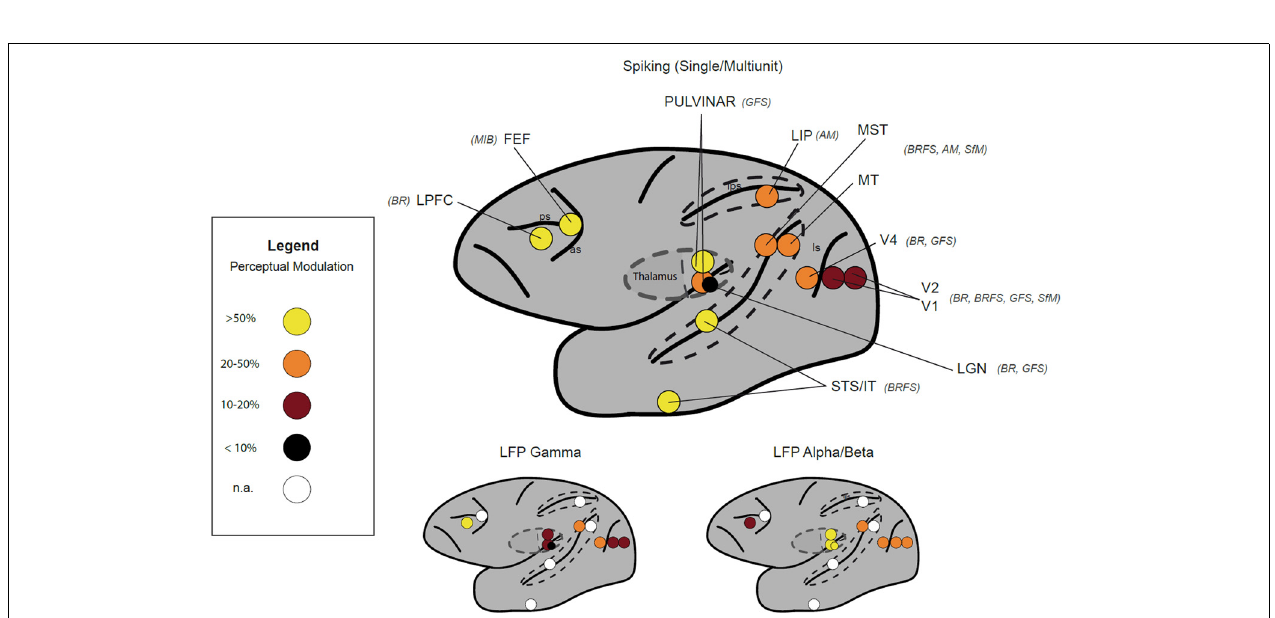
FIGURE 6 | Neurophysiological correlates of visual awareness measured in different studies by intracranial recordings in monkeys and humans. Color code depicts the reported percentage of sites modulated for a given signal:SingleUnit/Multiunit(upperrow),LocalFieldPotentials(LFP)(lowerrow) Gamma band (40–100Hz), Alpha/Beta (8–30Hz). Stimulus paradigms used in the depicted studies are in brackets next to the area label (see Figure 5 ). Unavailable information for a given area is given as white circle. Data were derived from following publications: V1-V4 (Leopold and Logothetis, 1996; Gail